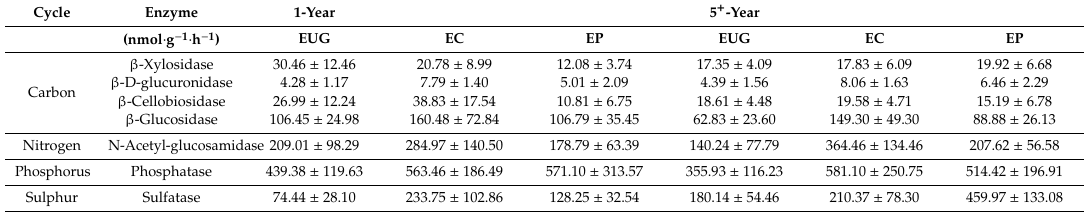
Table 2. The soil enzyme activity in eucalyptus plantations with di ff erent ages and species. Cycle